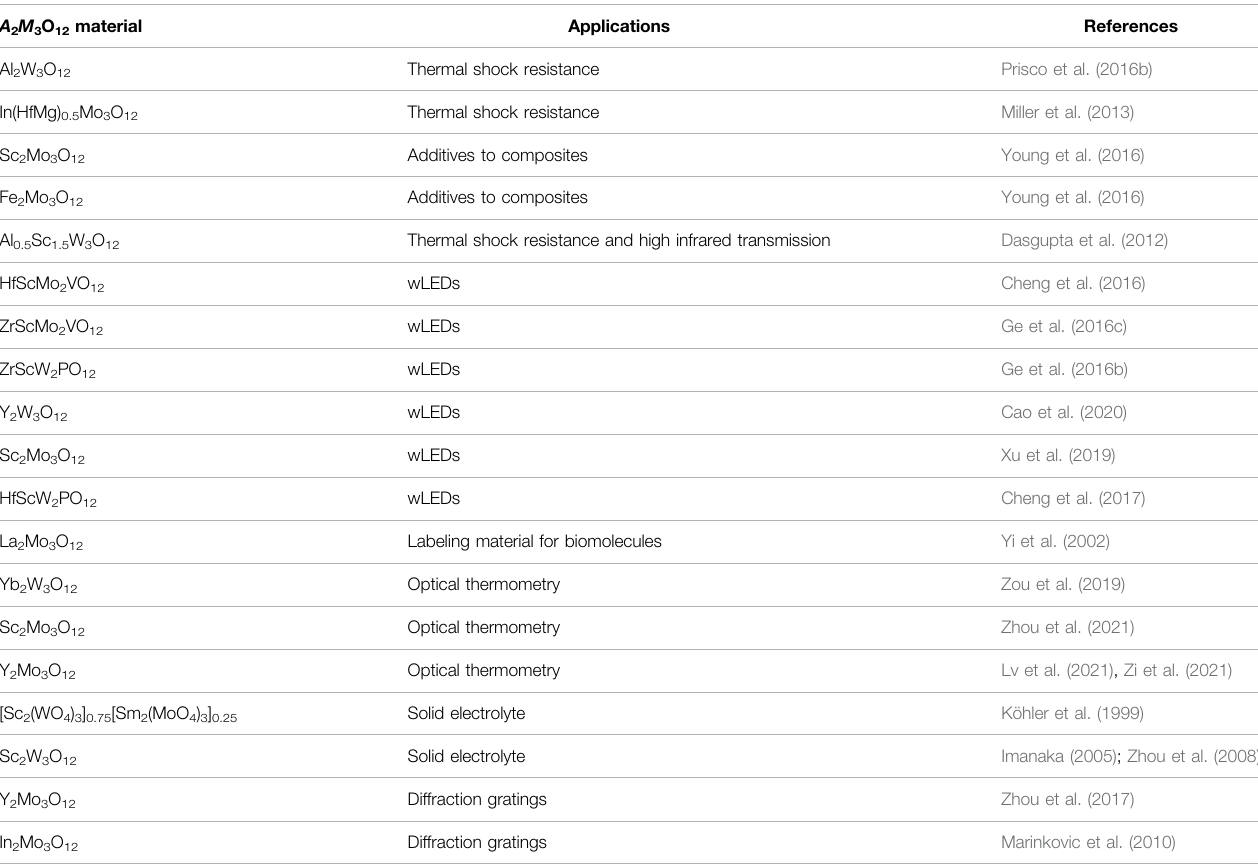
TABLE 4 | A 2 M 3 O 12 materials and their potential